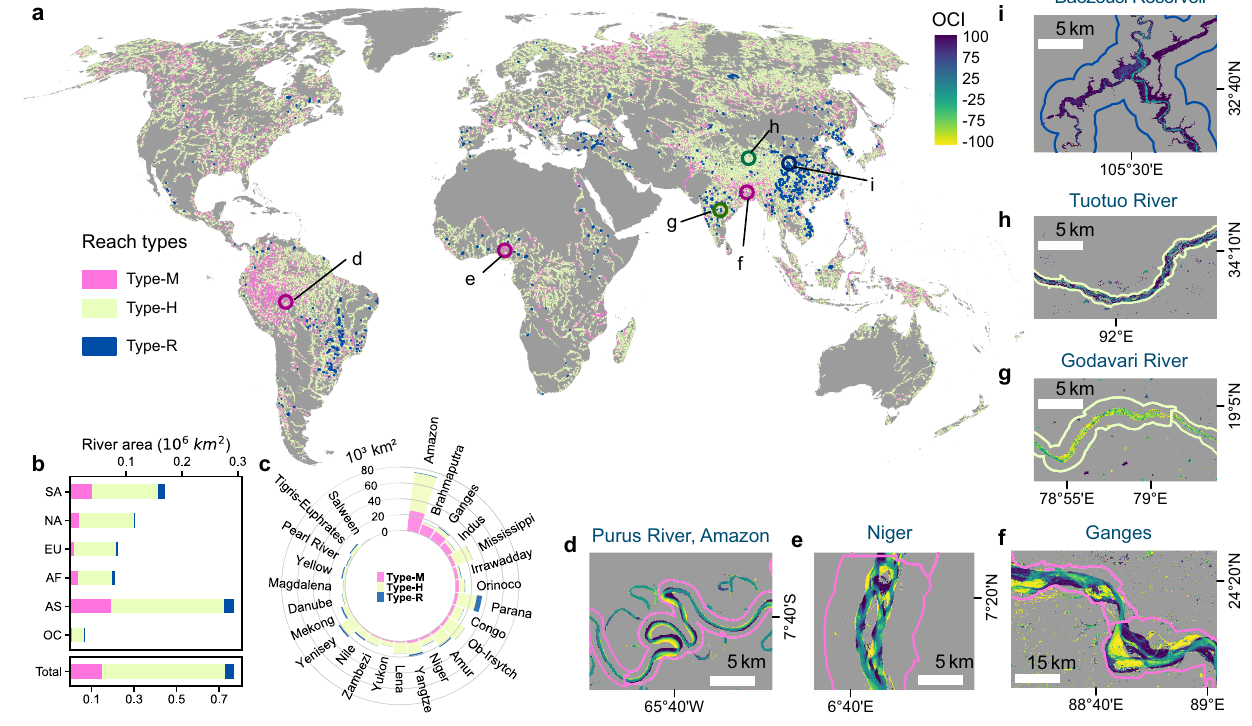
Fig. 1 | The global distribution of different types of river extent changes in the early 21st century: morphological dynamics (Type-M), hydrological signals (Type-H), and new reservoir-type river reaches (Type-R). a The global map of different types of changes. b , c The areal statistics of different reach types in six